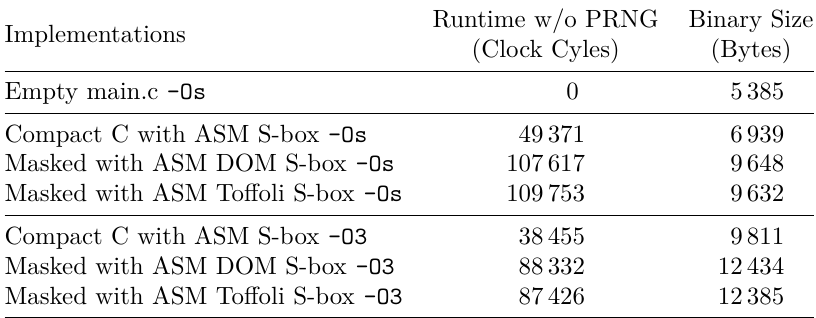
Table 2: Comparison of computing 18 rounds of Keccak - f [200] using different implemen- tations. Numbers do not include generation of randomness: The DOM approach requires 5 random bits per S-box (200 + 200 × 18 = 3800 bits in total), which can be reduced with techniques such as Changing of the Guards. The Toffoli approach requires just 200 + 40 in total when implemented as proposed for Circuit